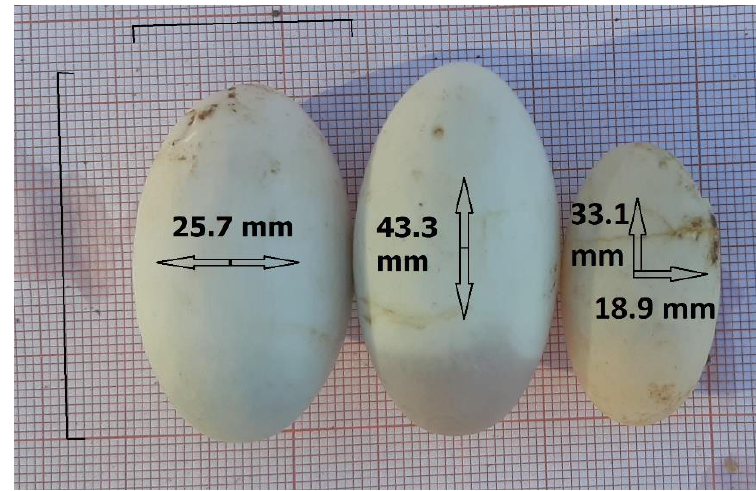
Figure 3. Demonstration of the morphometric differences between the widest (left egg), the longest (middle egg), and the egg close to the minimum dimensions (right egg) recorded during the present study.